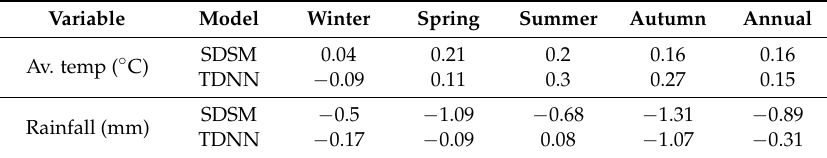
Table 2. Seasonal and annual model biases for statistical downscaling model (SDSM) and TDNN for validation period.